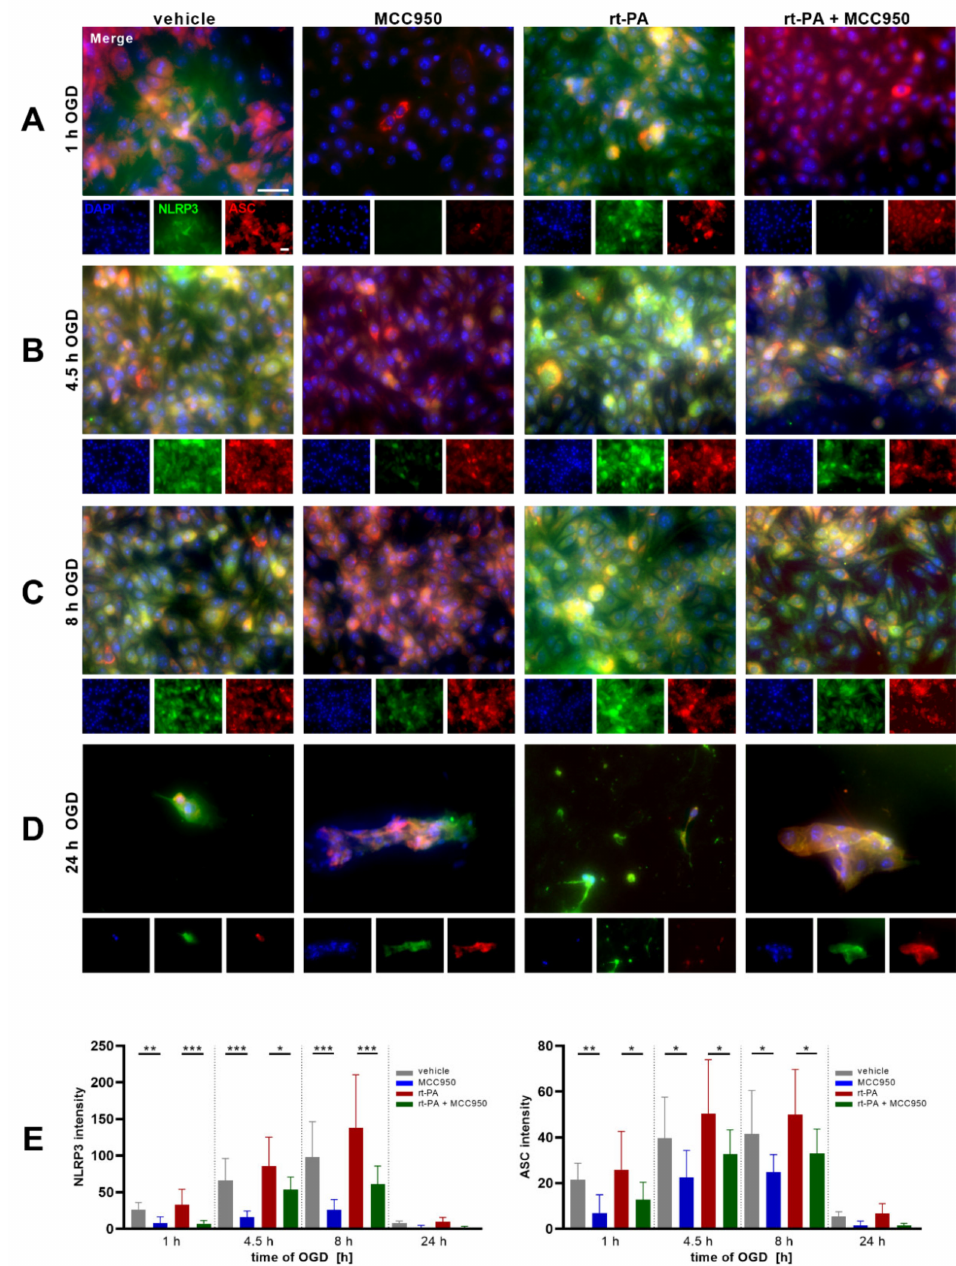
Figure 2. MCC950 treatment reduces NLRP3 and ASC expression under OGD. Representative NLRP3 (green), ASC (red), and DAPI (blue) immunofluorescence stainings of bEnd5 after ( A ) 1 h, ( B ) 4.5 h, ( C ) 8 h, or ( D ) 24 h of OGD (1% O 2 , 5% CO 2 , 95% humidity, 37 ◦ C, 1 g/L glucose) either with vehicle, MCC950, rt-PA, or dual rt-PA and MCC950 treatment. ( E ) Quantification of NLRP3 (left) and ASC (right) expression by intensity measurement of the immunofluorescent stainings ( n = 15 out of 3 independent experiments); 20 × objective; scale bar = 20 µ m; scale bars account for all images. Merged images are enlarged by a factor of 3. Data was analyzed by 1-way ANOVA with post hoc Tukey adjustment. * p < 0.05; ** p < 0.01; and *** p <